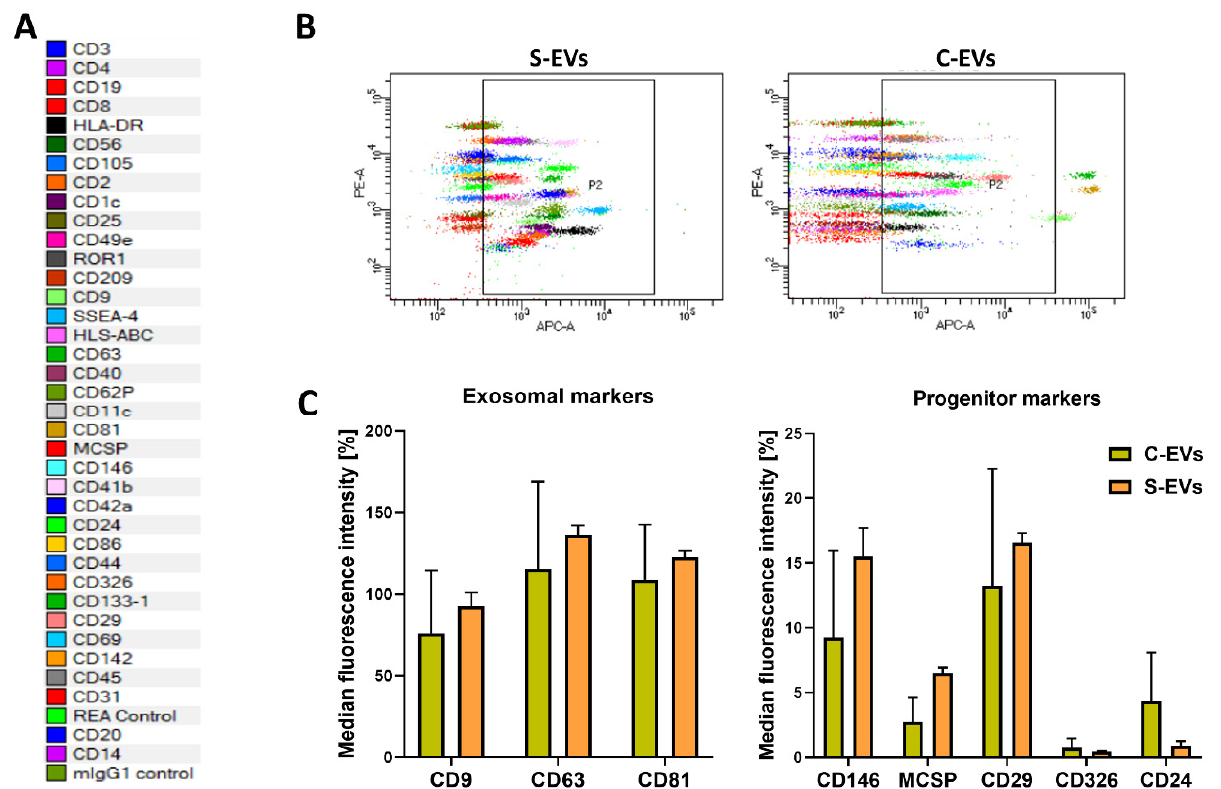
Figure 2. Characterization of S-EVs. ( A ) List showing the 39 antibodies used in the assay and their respective colors in dot plots. ( B ) MACSPlex representative dot plots showing the S-EVs and C-EVs distribution of allophycocyanin (APC)-stained bead populations. ( C ) Quantification of the median APC fluorescence for each bead population after background correction, clustered in exosomal and progenitor markers. The progenitor markers were normalized to median fluorescence intensity of exosomal markers. Data is expressed as the average of three independent experiments ± SD.